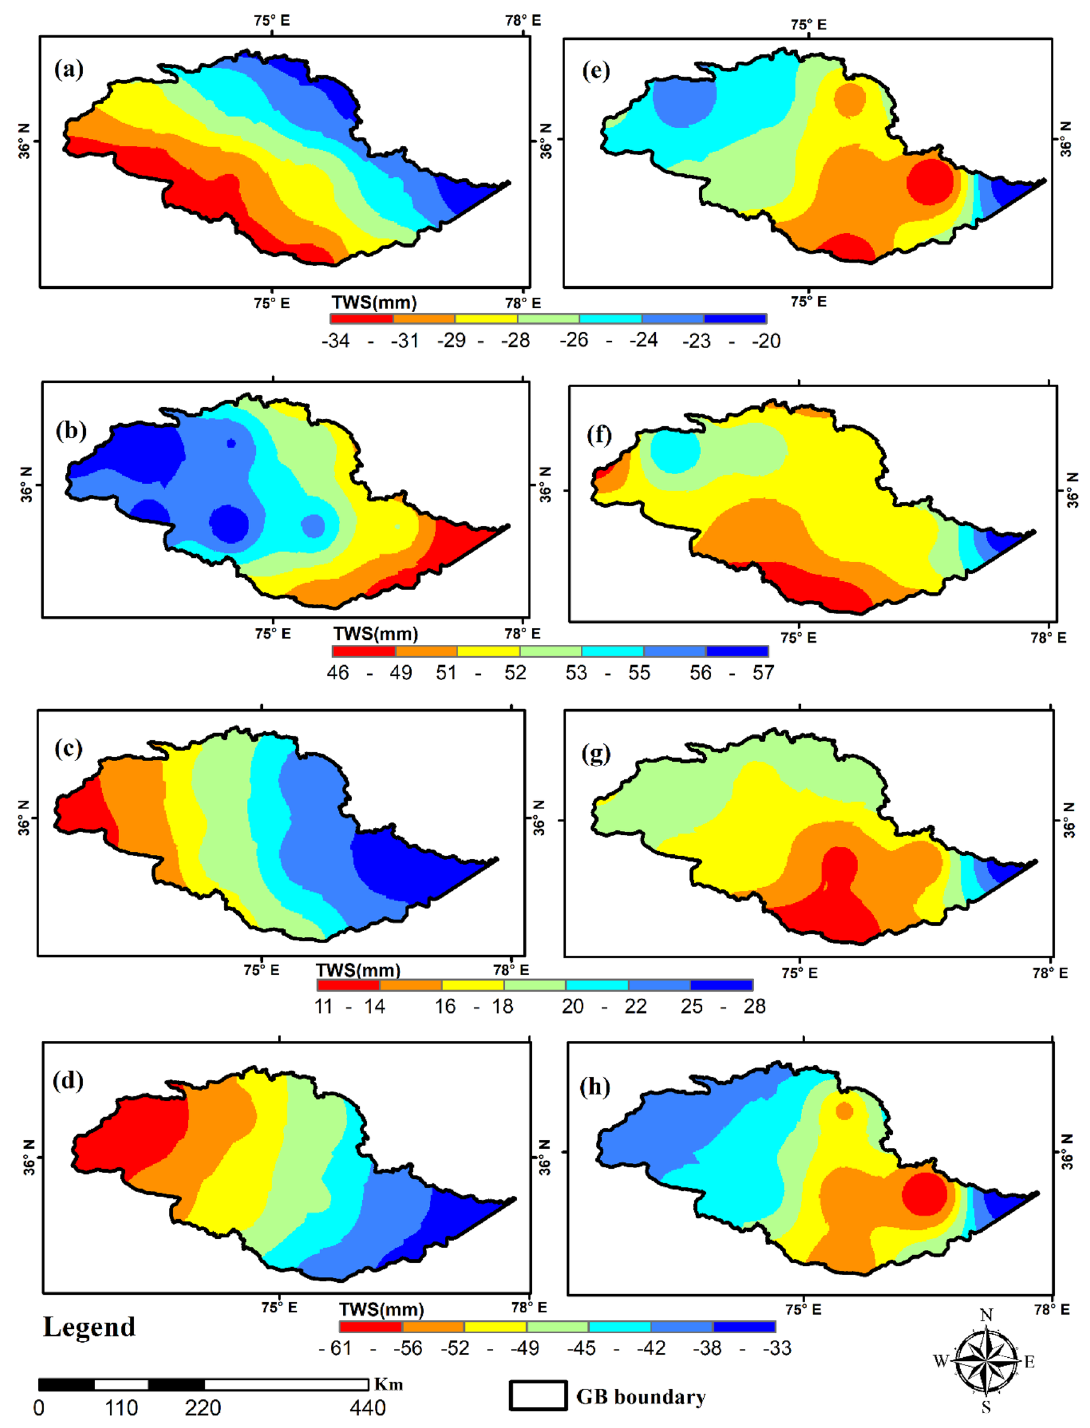
Fig. 4 Spatial variation of TWS estimated by GRACE ( a – d ) and GLDAS-Noah model ( e – h ) for GB concerning winter ( a , e ), spring ( b , f ), sum- mer ( c , g ), and autumn ( d , h ), respectively, for